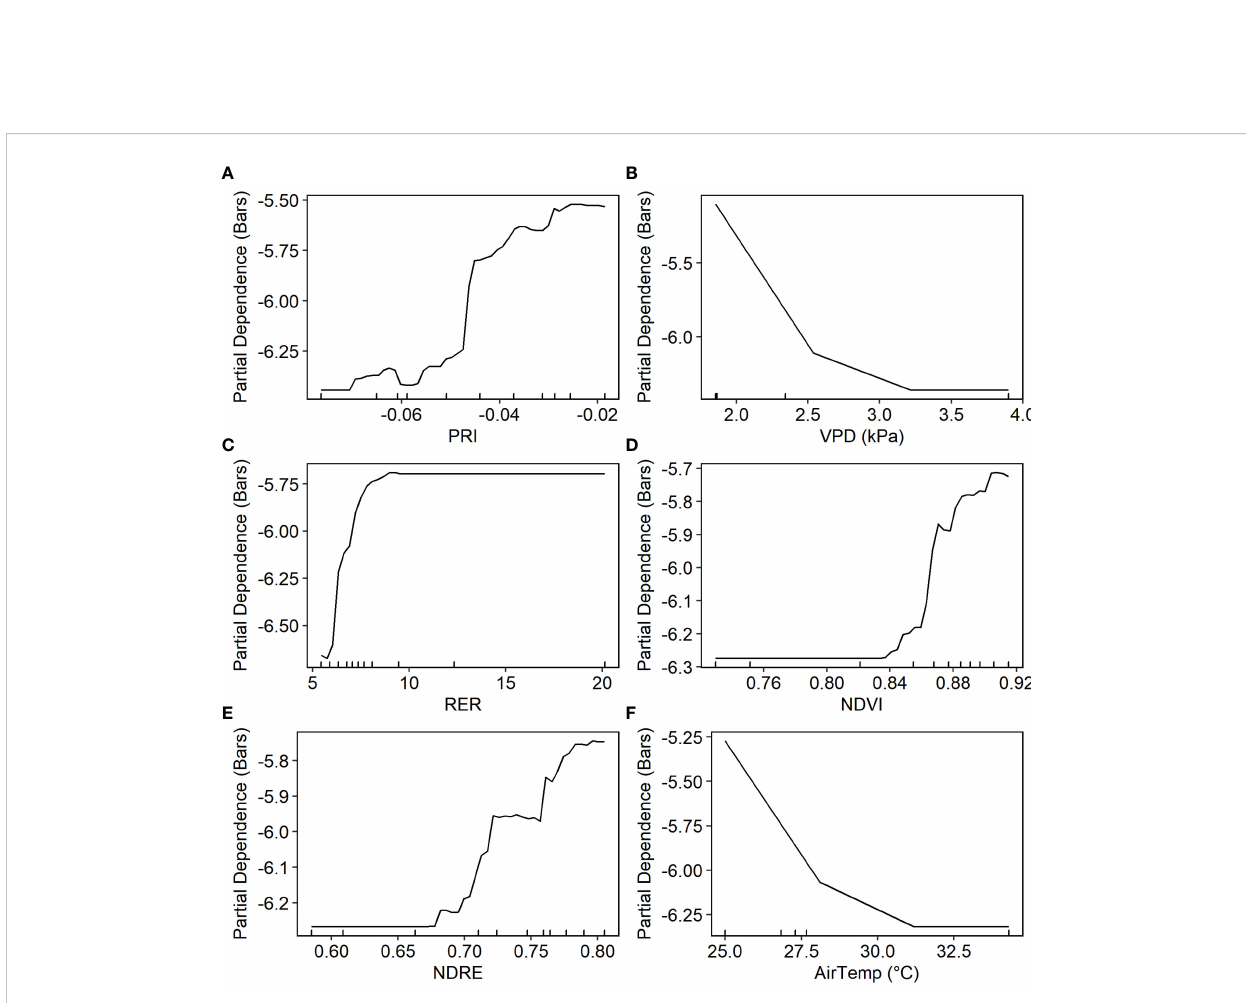
FIGURE 11 Partial dependence plot of the random forest model based on the data from the unmanned aerial vehicle multispectral imagery and weather